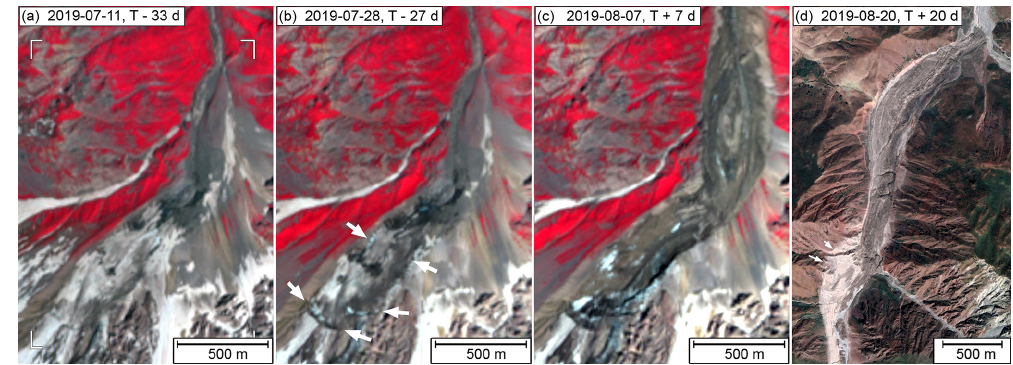
Figure 3. S2 false color imagery capturing the evolution of the detachment dp-19. From (a) to (b) crevasses open around the glacier outline (arrows), while the middle part of the glacier remains snow covered. (c) Exposed glacier bed after detachment, and (d) runout zone of the resulting debris flow; arrows indicate the maximum height of the trim line. (a–c) Copernicus Sentinel data (2019). (d) © Google, Maxar Technologies.